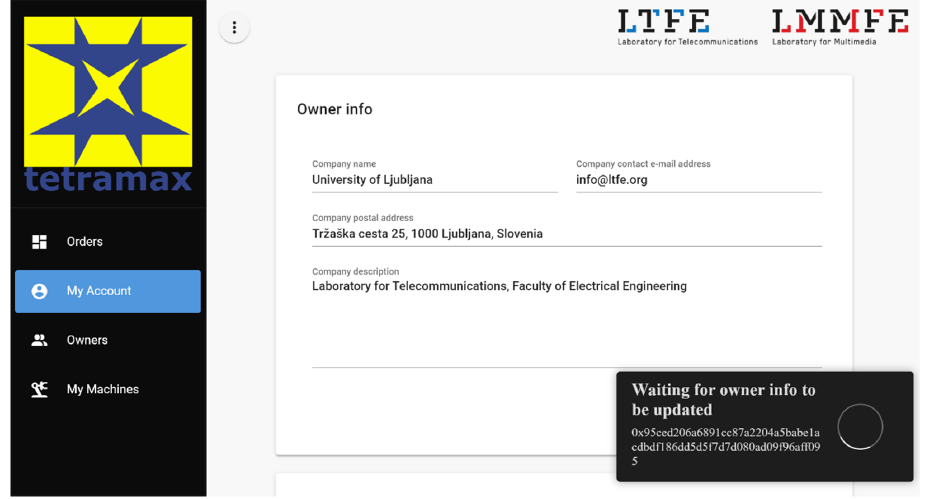
Figure 5. Web management and monitoring user interface.